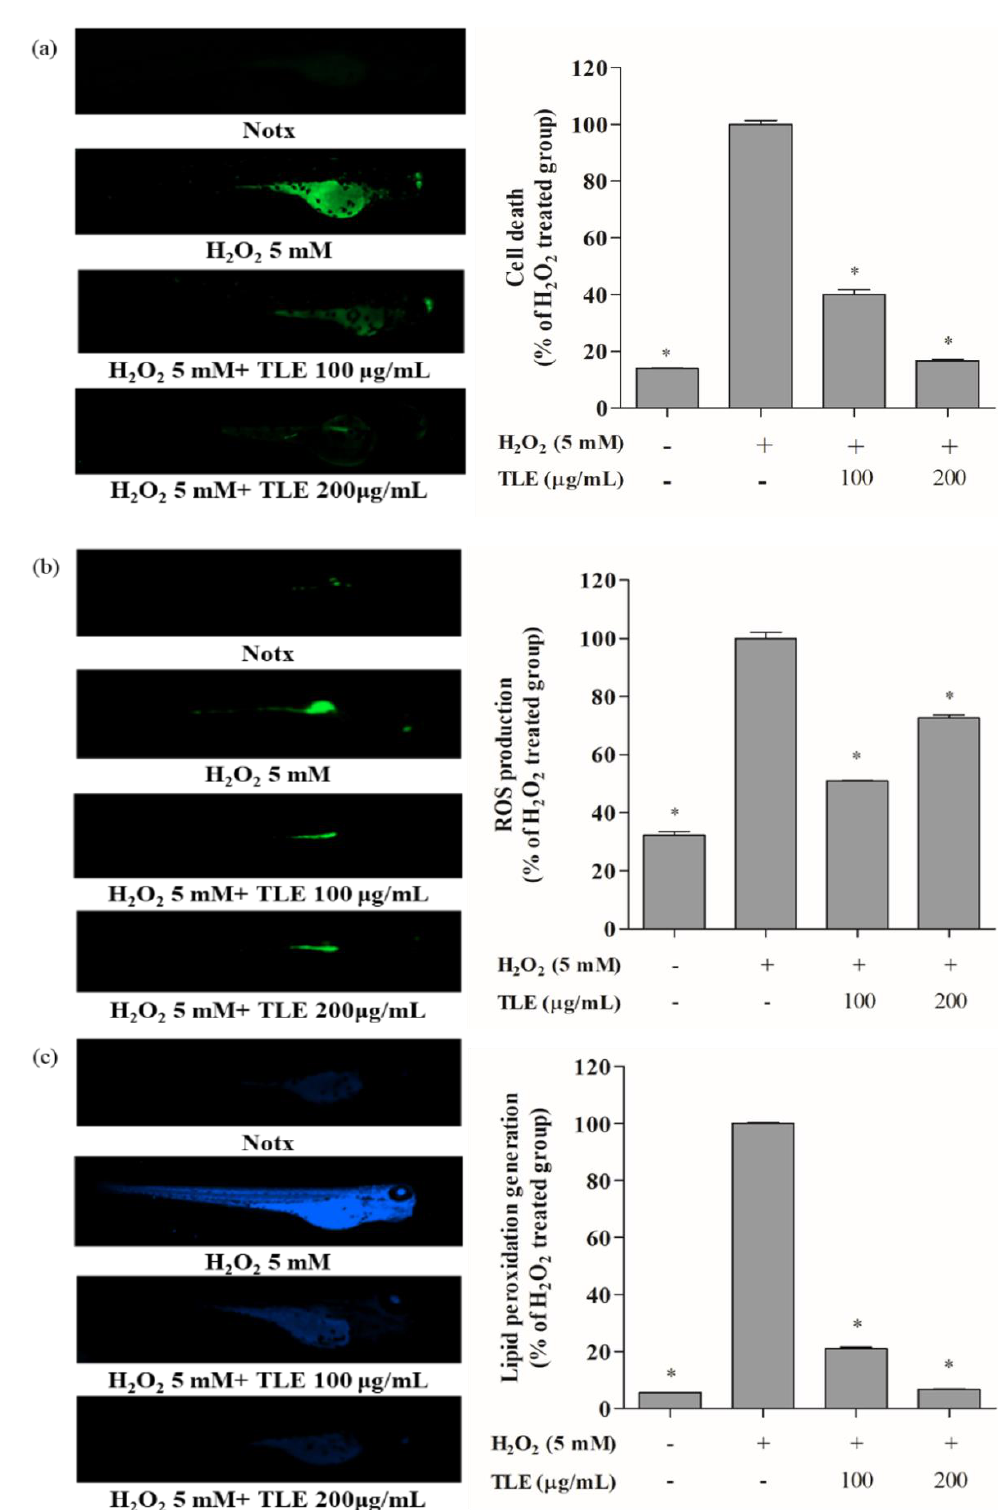
Figure 6. Cell death, ROS production, and lipid peroxidation in zebrafish. Zebrafish embryos were pre-treated with TLE (50, 100, and 200 µ g/mL) and/or treated with H 2 O 2 (5 mM). Imaging of ( a ) cell death, ( b ) ROS production, and ( c ) lipid peroxidation was performed using fluorescence microscopy. The fluorescence intensity of zebrafish was quantified using ImageJ software. The data were measured in triplicate and expressed as the mean ± SE. * p < 0.05 compared with the H 2 O 2 - treated group.